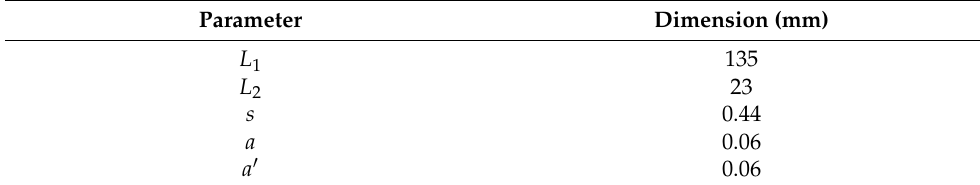
Table 1. Dimensions of the RFID temperature sensor tag.